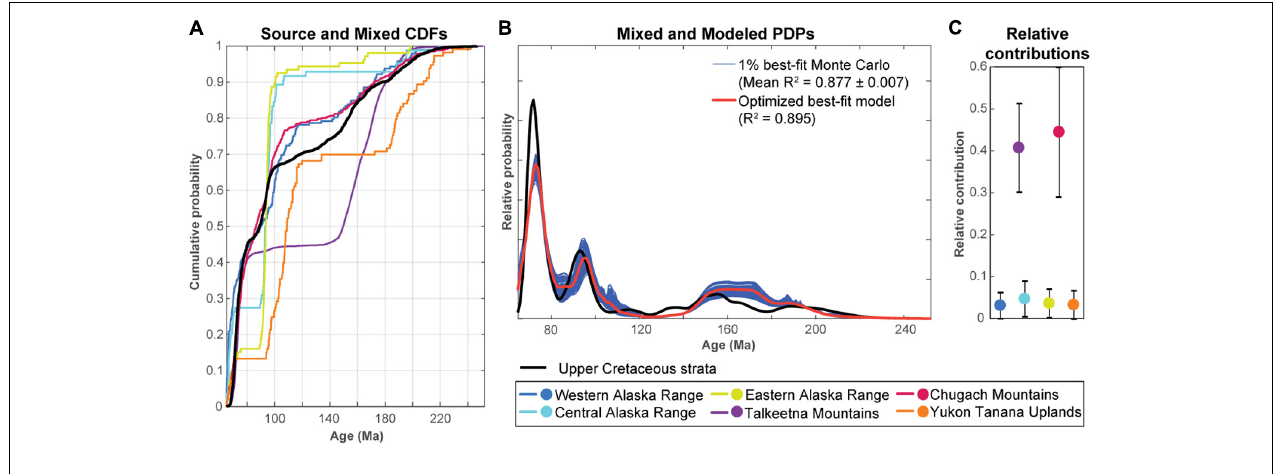
FIGURE 4 | Same as Figure 3 except for the Upper Cretaceous strata.